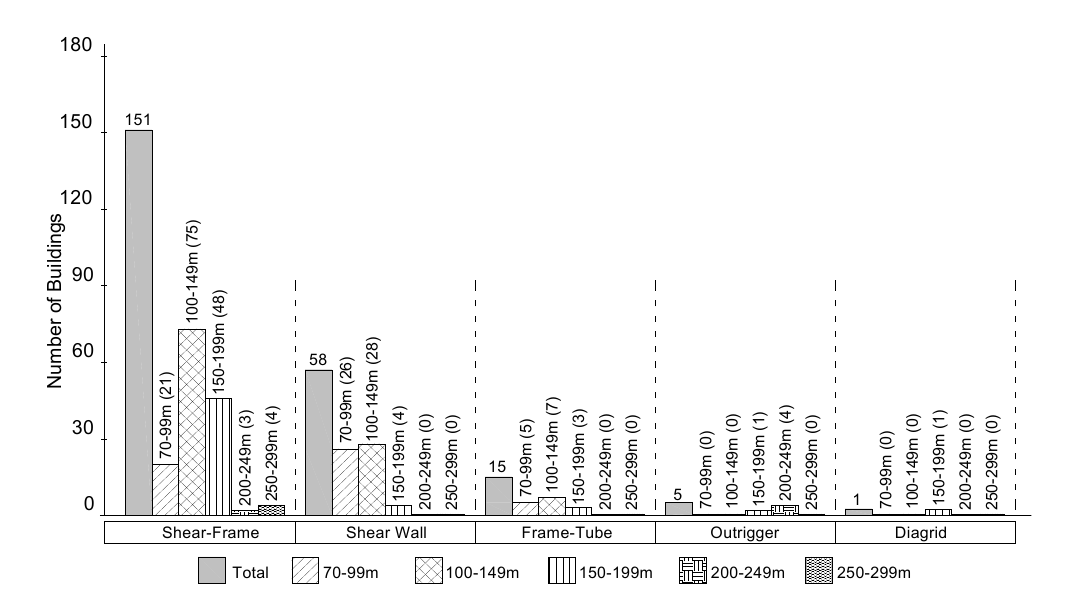
Figure 13. Relation between building height and structural system.